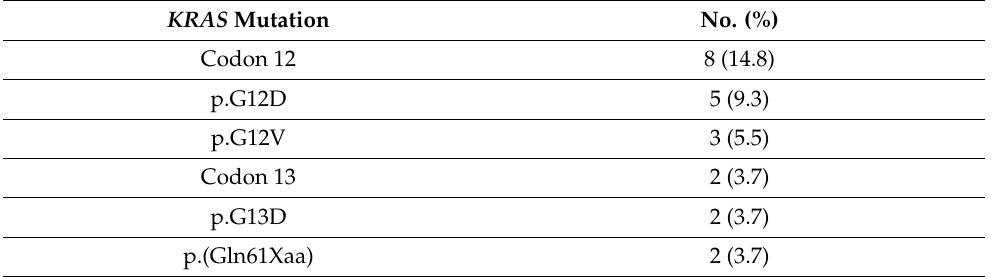
Table 4. KRAS mutation analysis.